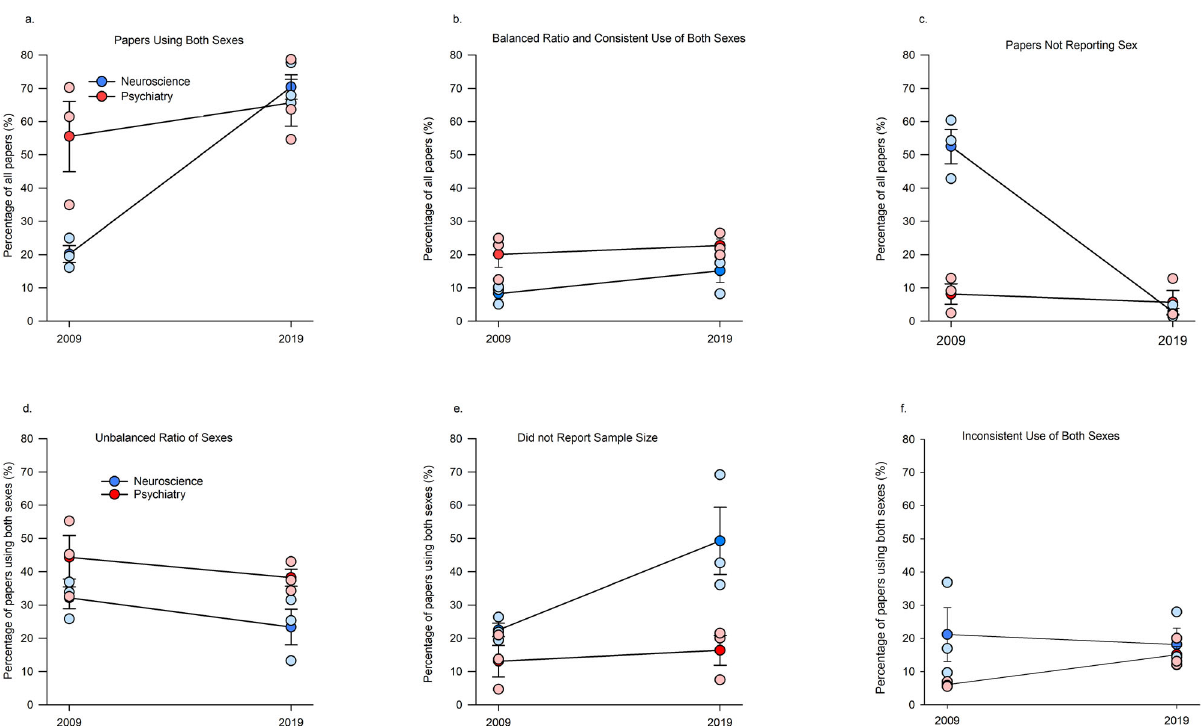
Fig. 3 The percentage of papers in the sampled in 2009 and 2019 in neuroscience and psychiatry that reported use of both sexes, and the breakdown of how papers were using both sexes. Plotted are the percentage of proportional papers within each journal and year, n = the number of research papers within each category. a Percentage of papers reporting studies using both sexes in any aspect of the paper, regardless of consistency or balanced ratios. The percentage of papers reporting studies including males and females increased signi fi cantly for neuroscience (Newman – Keul ’ s post hoc p = 0.003, two-tailed) but not psychiatry papers (interaction effect of year by discipline: F (1,8) = 8.844, p = 0.017, Newman – Keul ’ s post hoc p = 0.319, two-tailed). Number of papers: neuroscience 2009 n = 316, 2019 n = 646; psychiatry 2009 n = 288, 2019 n = 249. b Percentage of papers reporting studies using both sexes consistently throughout the paper with balanced ratios of the sexes. Number of papers: neuroscience 2009 n = 130, 2019 n = 158; psychiatry